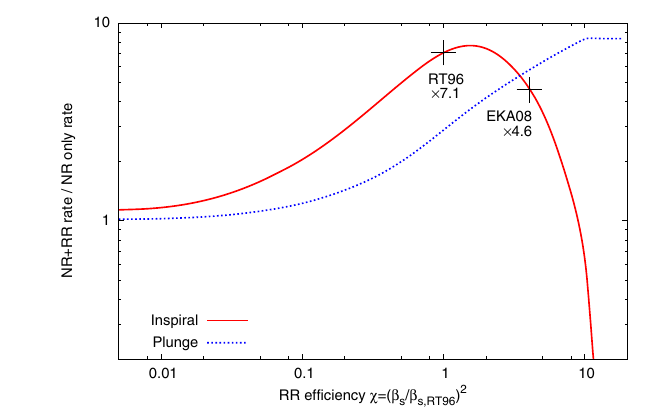
Fig. 45 Total event rates produced by relaxation and coherent relaxation normalised by the rates obtained by considering only relaxation. Image reproduced with permission from Eilon et al. (2009), copyright by